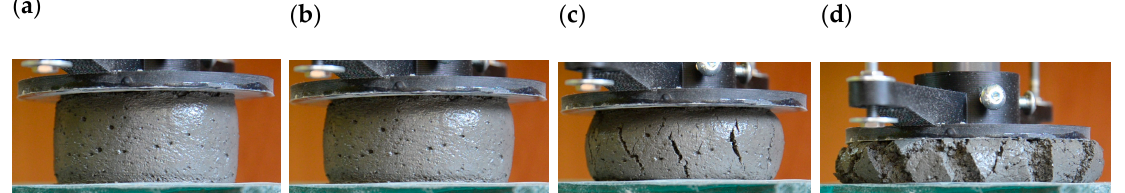
Figure 12. Analysis of specimen failure during the squeezing test—example 2.